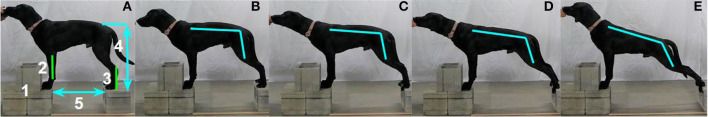
(A) Shows the Plank setup (1 shows the recommended three-block front object), starting position [2 illustrates a vertical distal forelimb and 3 illustrates vertical metatarsals (rear pastern)] and measurements (4 is the hip height and 5 is the distance between the objects). (B–E) Show progression of the Plank [(B) Level 2, (C) Level 4, (D) Level 6, and (E) Level 8].